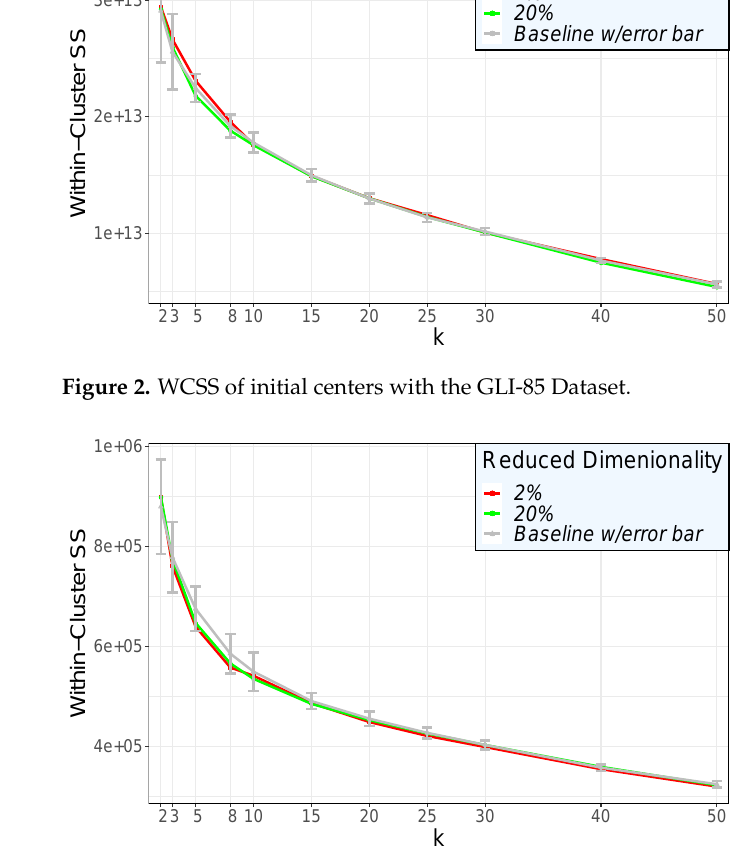
Figure 3. WCSS of initial centers with the SMK-187